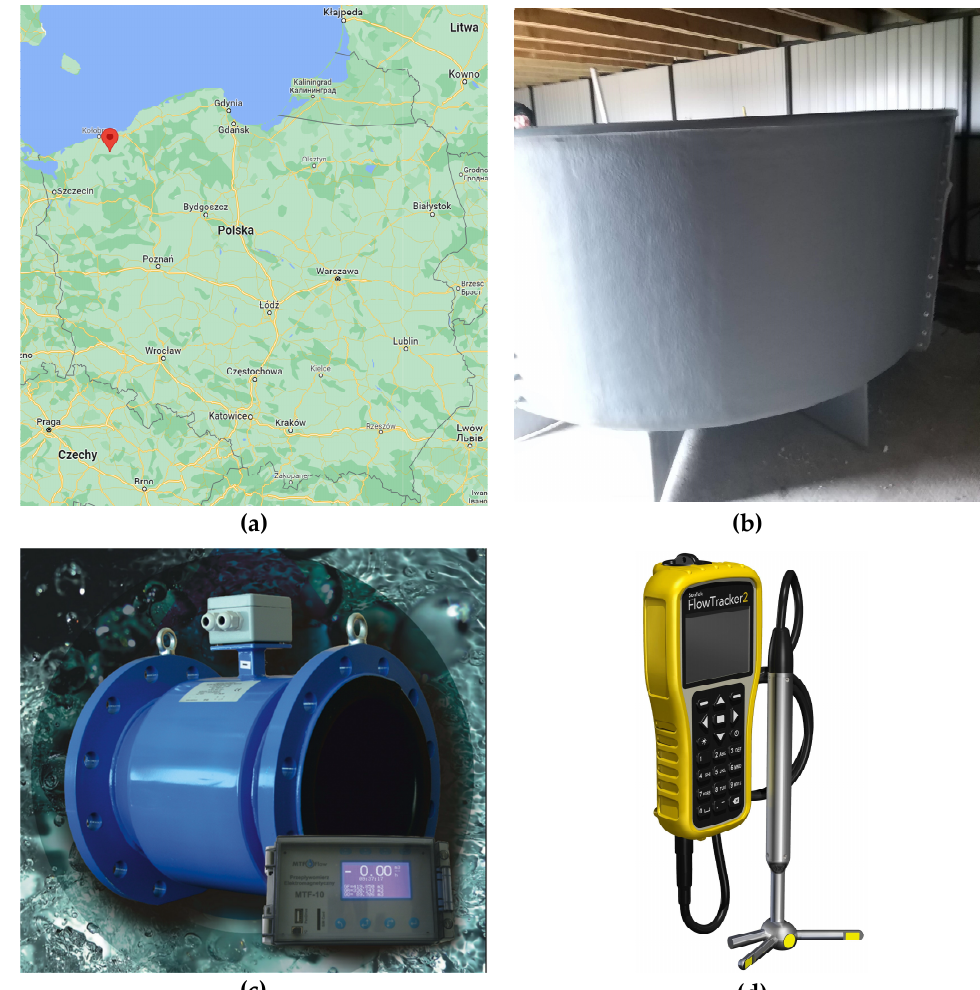
Figure 1. Location of the RAS fish farm and the equipment used in experiments: ( a ) location of Gar- nki, Poland shown on the map; ( b ) fish tank type SDK-RT 29-68 mounted on site; ( c ) electromagnetic water-flow meter MTF-10 (source: http://www.mtfflow.pl accessed on 13 September 2022); ( d ) SonTek FlowTracker2 Handheld-ADV (source: https://www.ysi.com/flowtracker2 accessed on 13 Septem- ber